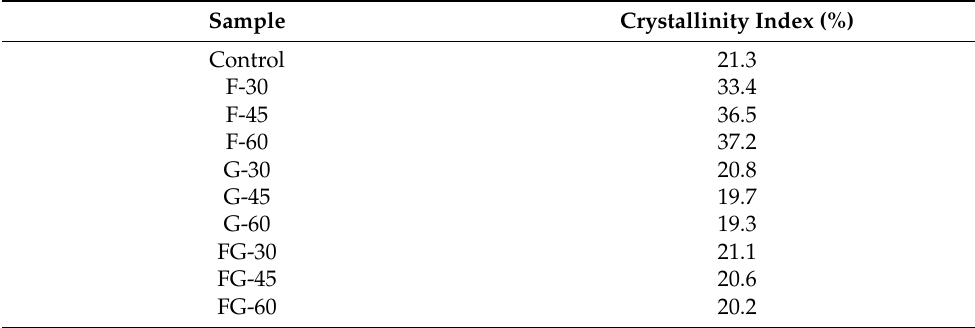
Table 2. Crystallinity Index of samples using different